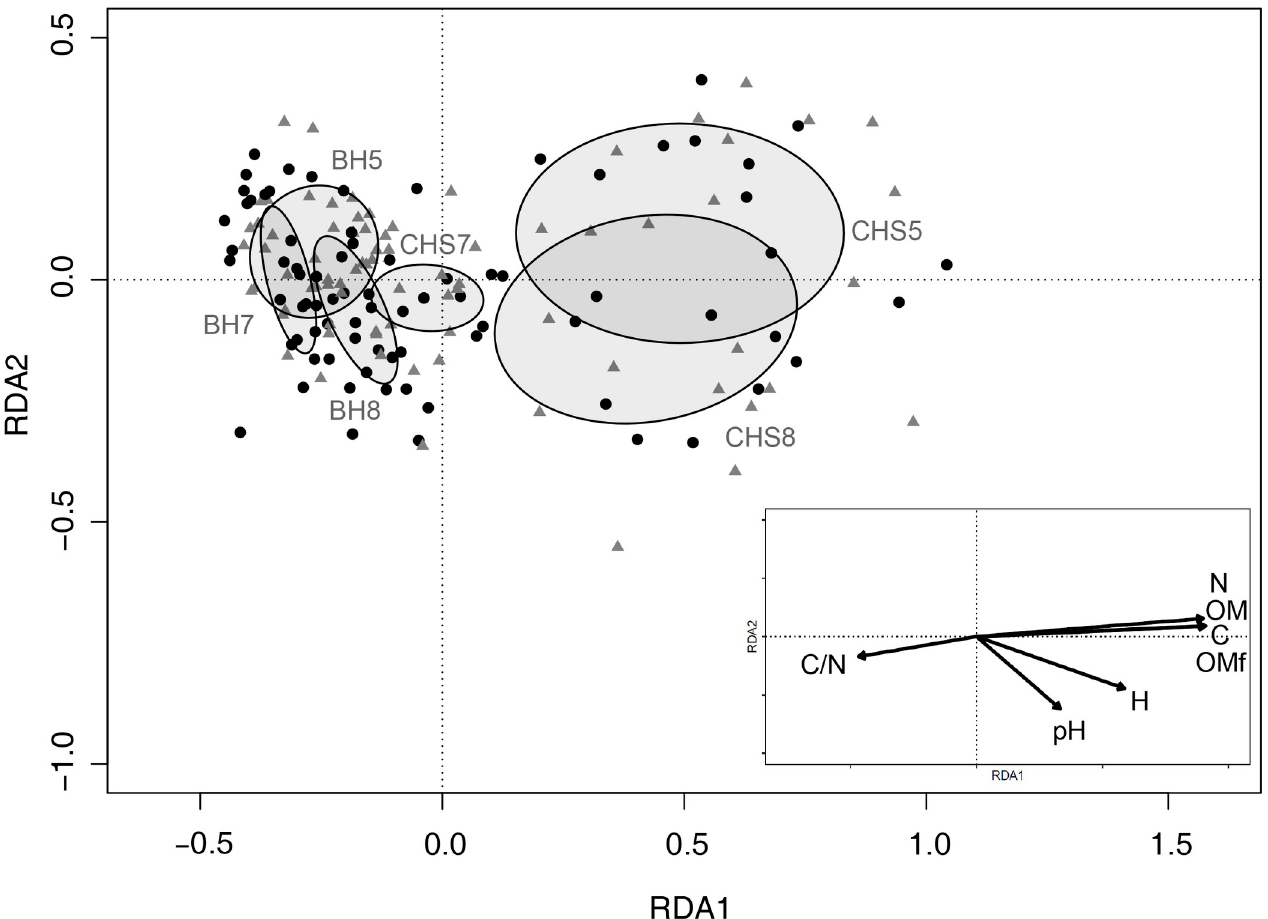
Fig 5. Redundancy analysis (RDA) of soil plots of the environments below house (BH) and chicken shed (CH) of the sampled farms (5, 7, and 8) as explanatory variables and soil physicochemical variables as response variables: Carbon/nitrogen (C/N), % humidity (H), % organic carbon (C), % total organic matter (OM), % organic matter fractions (OMf), % nitrogen (N) and pH. Each ellipse shows one of the six plots of the three sampled farms. The variable plot explained 50.9% of the covariability between soil variables.